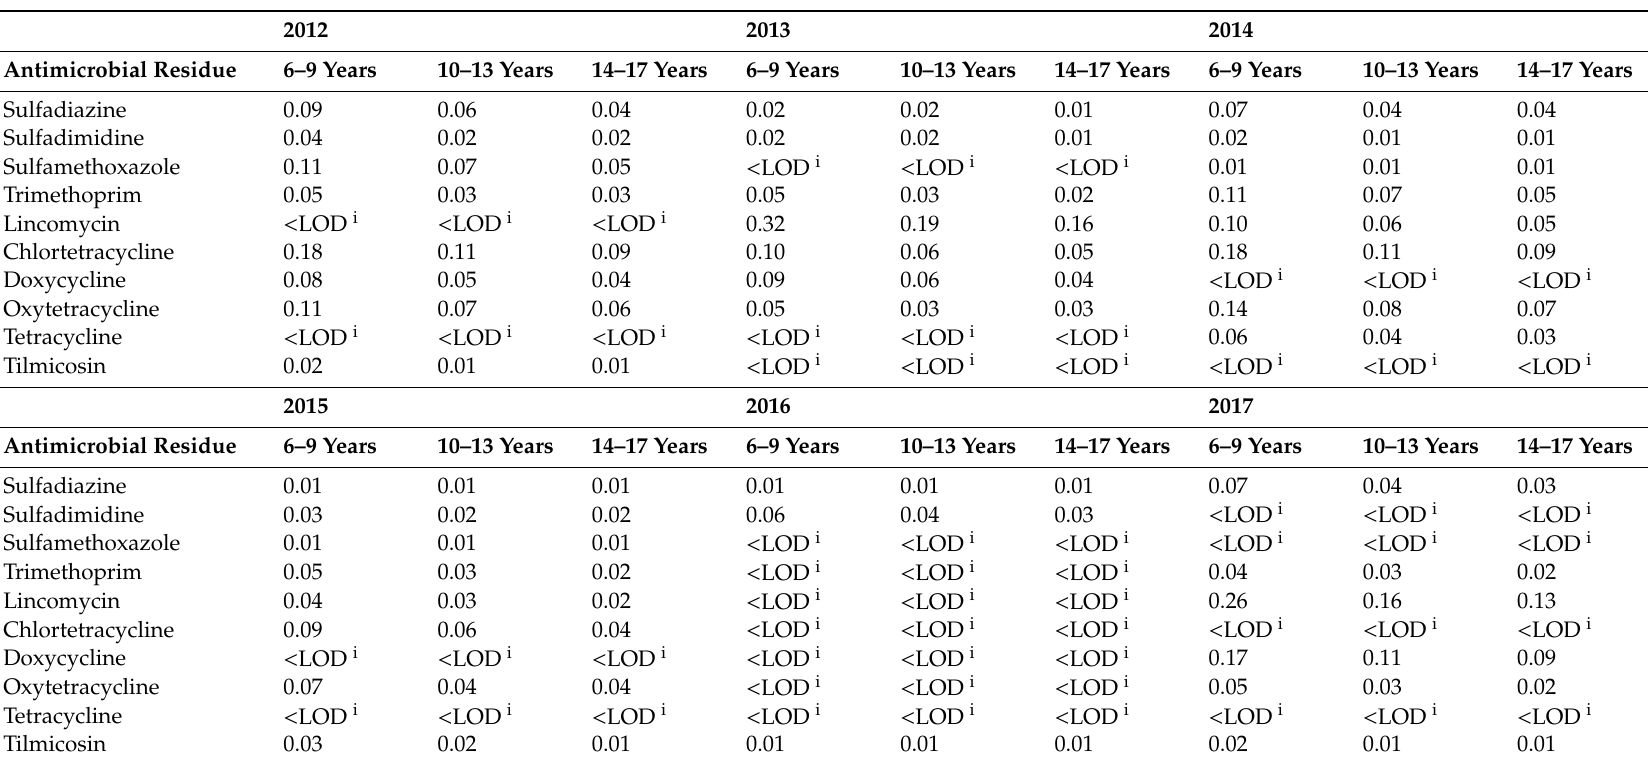
Table 3. Estimated daily intake values in µ g / kg bw / day of antibiotics in female young population in Cyprus between 2012 and